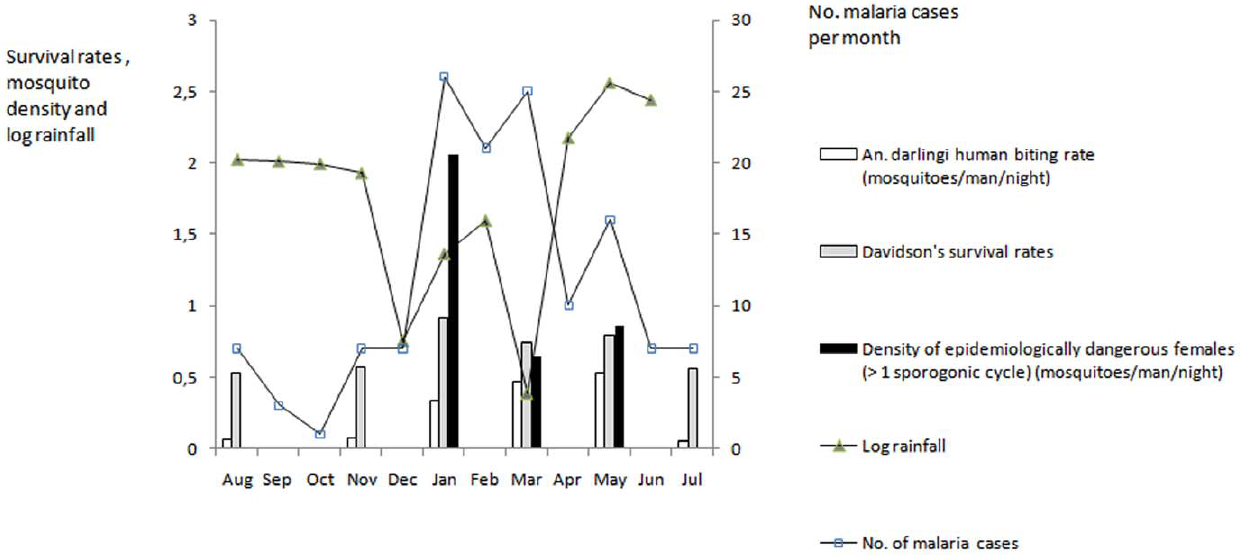
Figure 1. Davidson’s survival rates for Anophelesdarlingi females dissected, number of malaria cases, log rainfall, density of adult female mosquitoes and of epidemiologically dangerous mosquitoes. Data was obtained in Sideroad 19, from different collection periods, from August, 2003, to July, 2004. Number of malaria cases were obtained from January 2002 to December 2004.